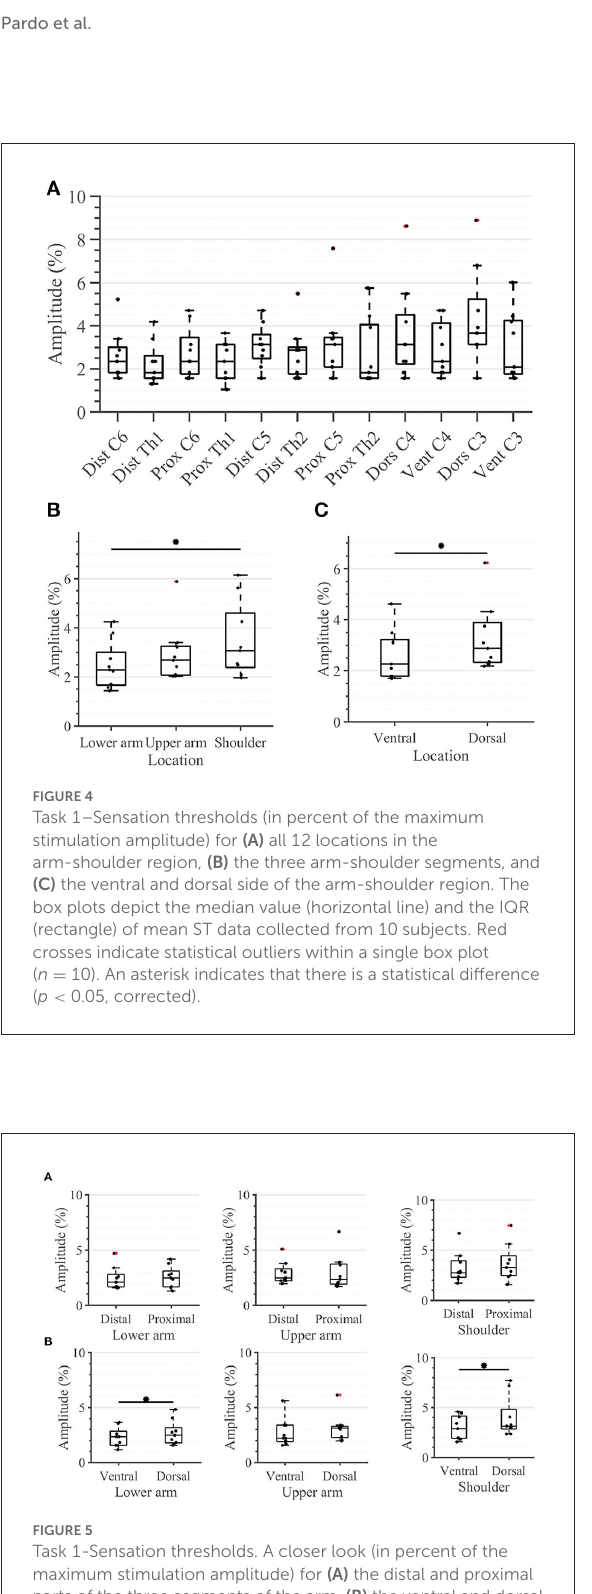
FIGURE7 Task 2 -Number of Distinct Intervals for all 12 locations in the arm-shoulder region (A) on the tested parts of the arm, as a combination of the results of the dermatomes in each region (the lower arm, the upper arm, and the shoulder), (B) and in each side (the ventral and dorsal) (C) , ( n = 10). The red points show